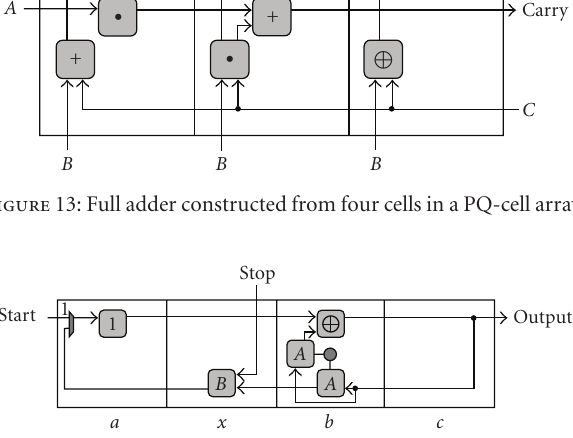
Figure 14: Ring oscillator constructed from four PQ-cells.